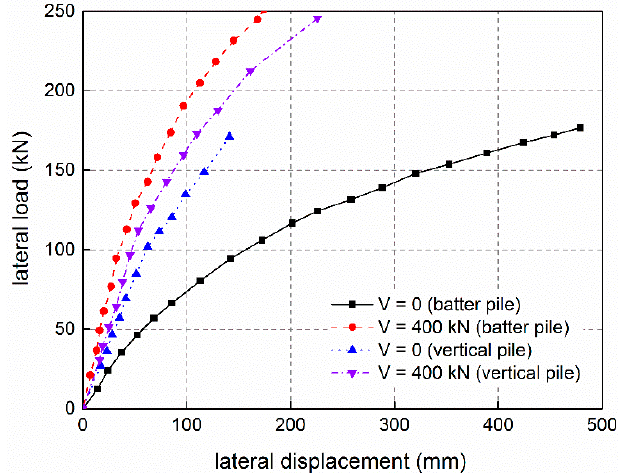
Figure 5. Lateral load vs. displacement of two piles under vertical loading (modified from Evans [36]).